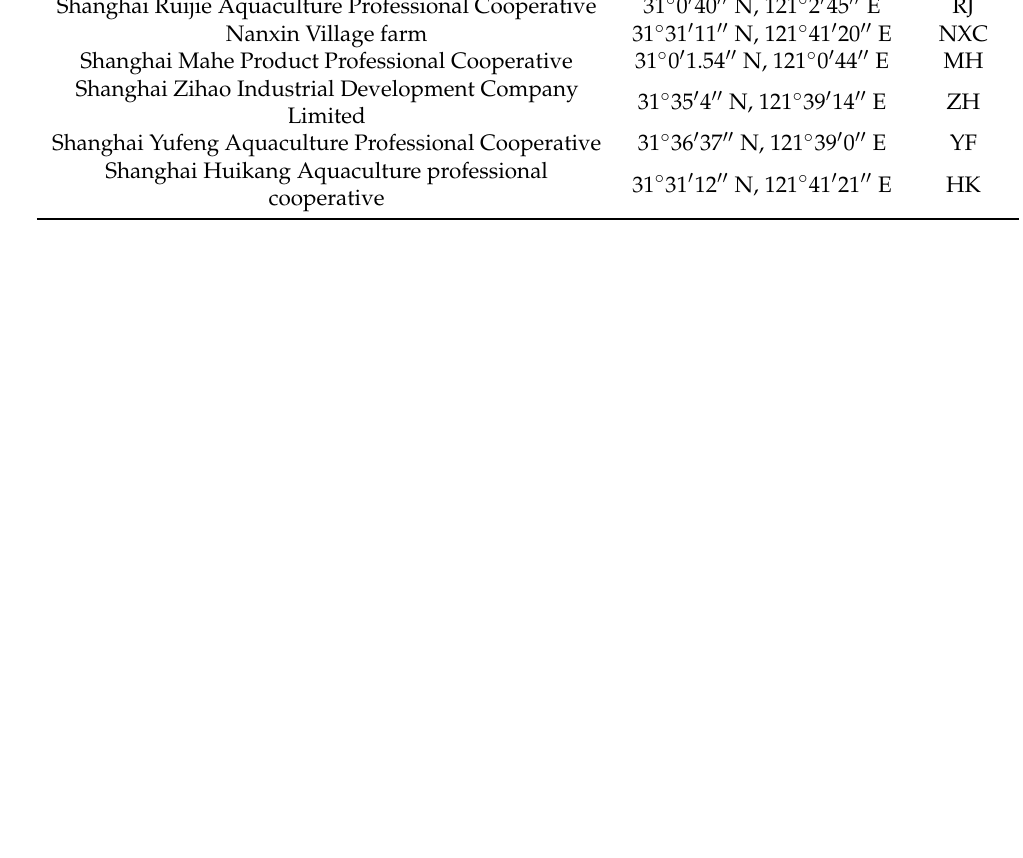
Table 1. Farm crab sampling site information. Name of